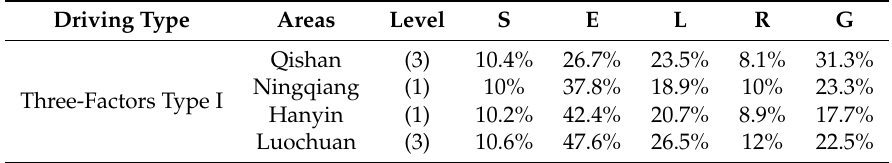
Table 7. Contribution rate of green development driving e ff ect of “Three-Factors Type I” areas. Driving Type Areas Level